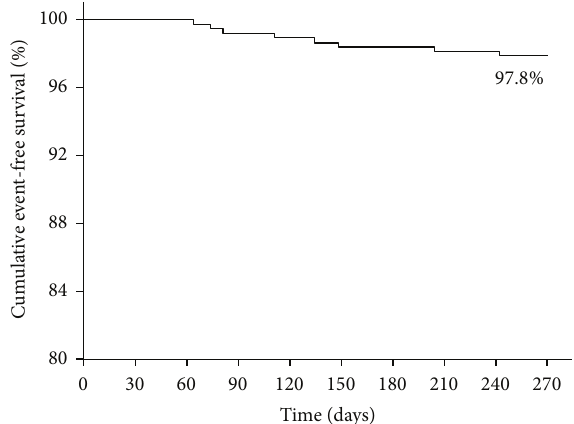
Figure 2: Cumulative event-free survival curve at 9-month follow-